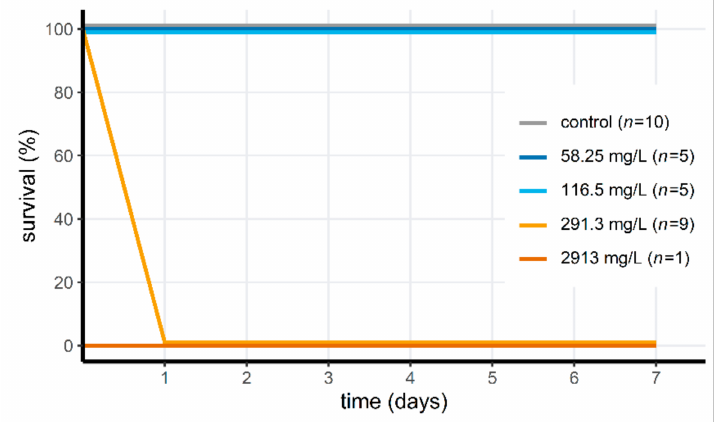
Figure 2. Survivalof Discoglossuspictus larvaeafterexposuretoperaceticacidconcentrationsof58.25mg/L (dark blue), 116.5 mg/L (light blue), 291.3 mg/L (light orange) and 2913 mg/L (dark orange). Notice the difference in number of animals ( n ) between the different